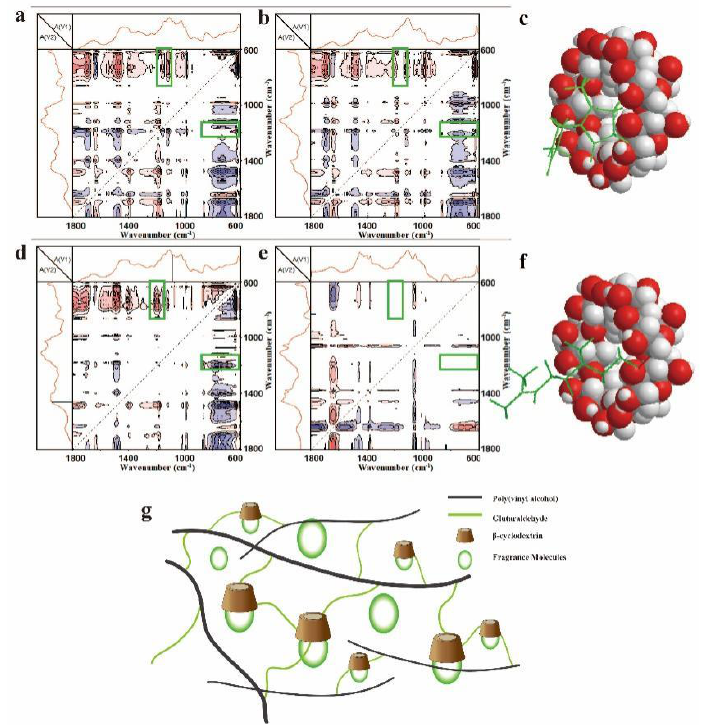
Figure 6. 2D Asynchronous FTIR spectra calculated from the temperature-dependent spectra of 25 °C – 77 °C in the range of 1800 – 600 cm −1 . ( a ) β -CD- cis -jasmone host-guest inclusion complex; ( b ) β - CD- cis -jasmone blend; ( c ) Interaction of β -CD with cis -jasmone; ( d ) β -CD-citronella host-guest inclusion complex; ( e ) β -CD-citronella blend. ( f ) Interaction of β -CD with citronella. Pink and blue areas represent the positive and negative correlation intensity, respectively. ( g ) Illustration of the distribution of fragrance molecules in PVA/CD/GA fibers.